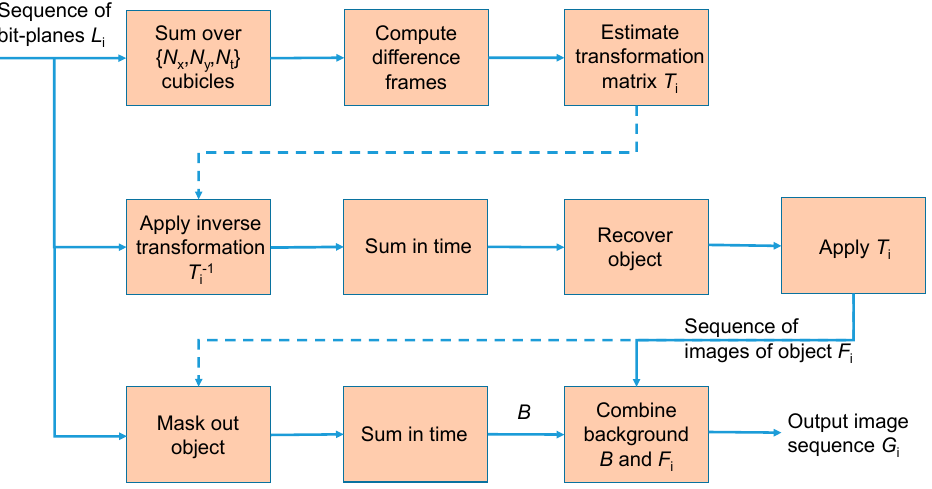
Figure 3. Block diagram indicating the steps in the tracking-reconstruction technique. The input is a sequence of bit-planes L i capturing a high-speed object. The scheme tracks the motion of this object (as defined by T i ) and outputs a higher bit-depth image sequence, G i .